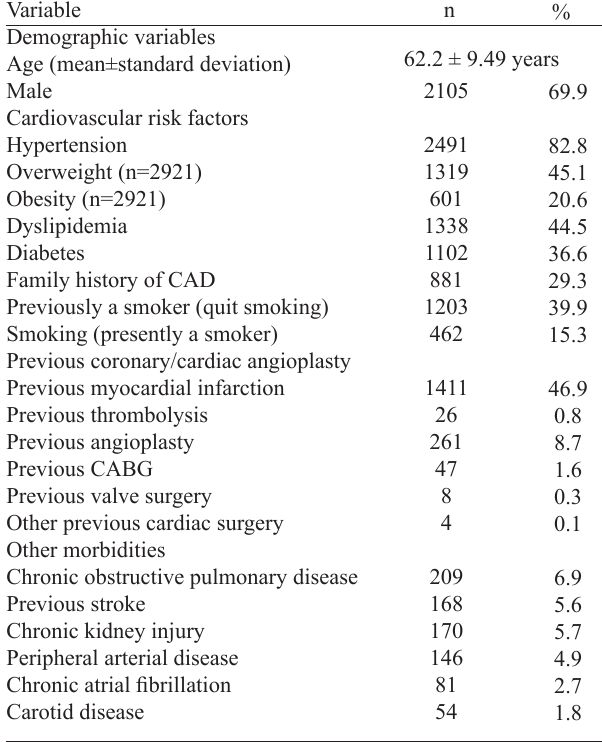
Table 1. Clinical-demographic characteristics of 3010 patients who underwent coronary artery bypass grafting, São Paulo,